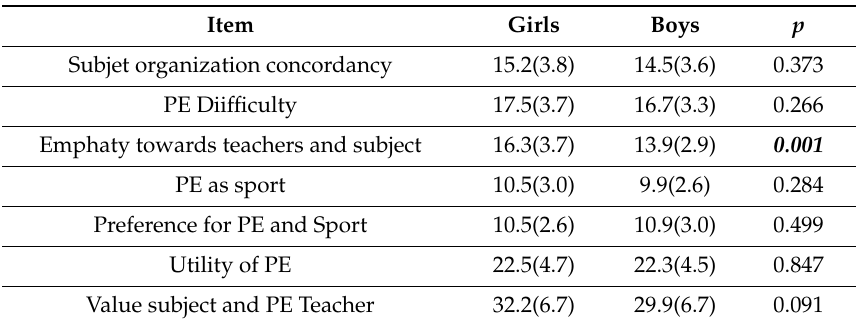
Table 4. Data from the questionnaire on attitude toward physical education in girls and boys (Mean and SD)—pre-intervention.